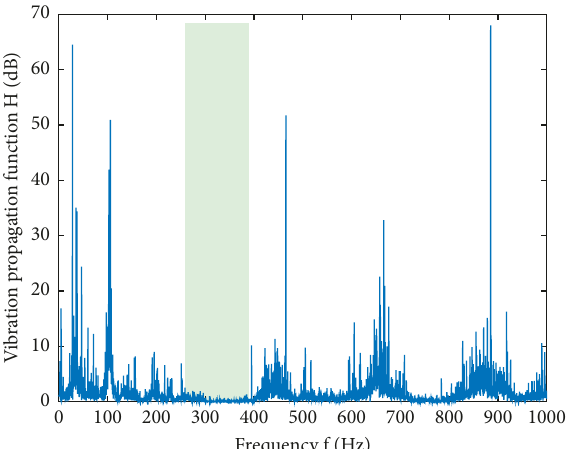
Figure 22: Vibration propagation function of response 3.